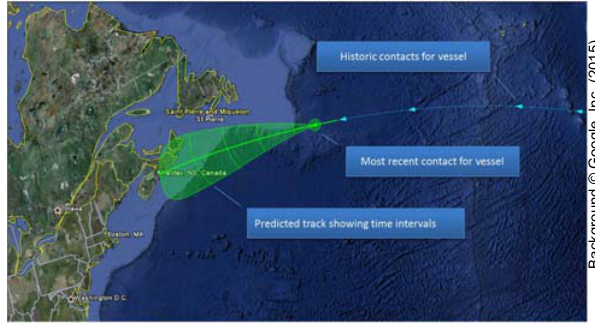
Figure 1. Conceptual Display for Ship Position Prediction Our ship tracker employs Bayesian probability analysis using the ship position, heading and speed with a great circle economic motion constraint to derive a track, track uncertainty and 10-hour track prediction beyond the available data